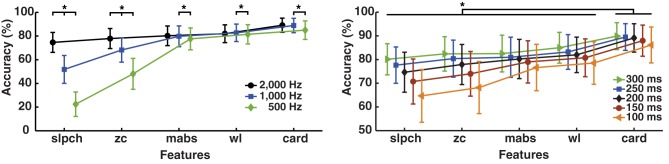
Effect of sampling frequency and time window length. Change in accuracy of myoelectric pattern recognition (MPR) owing to variations of sampling frequency (left inset), and the length of the time window used to extract the EMG features (right inset). Eleven movements (IM data) were classified using LDA and single EMG features (Hudgins' set and cardinality). The dynamic part of the contraction was included during signal processing (cTp = 0.7). The marker “*” represents statistical significance at p < 0.05.